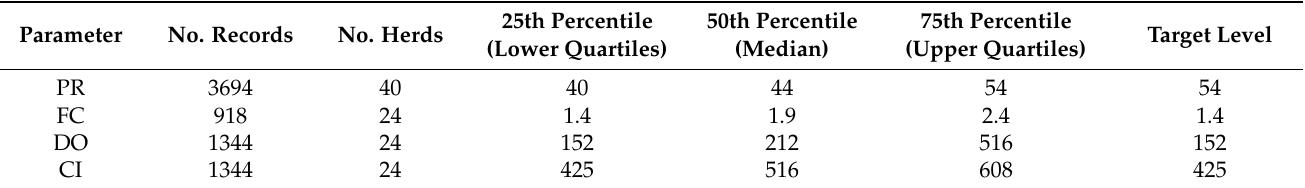
Table 7. Target level of reproductive performance in smallholder herds at 25th to 75th percentiles.